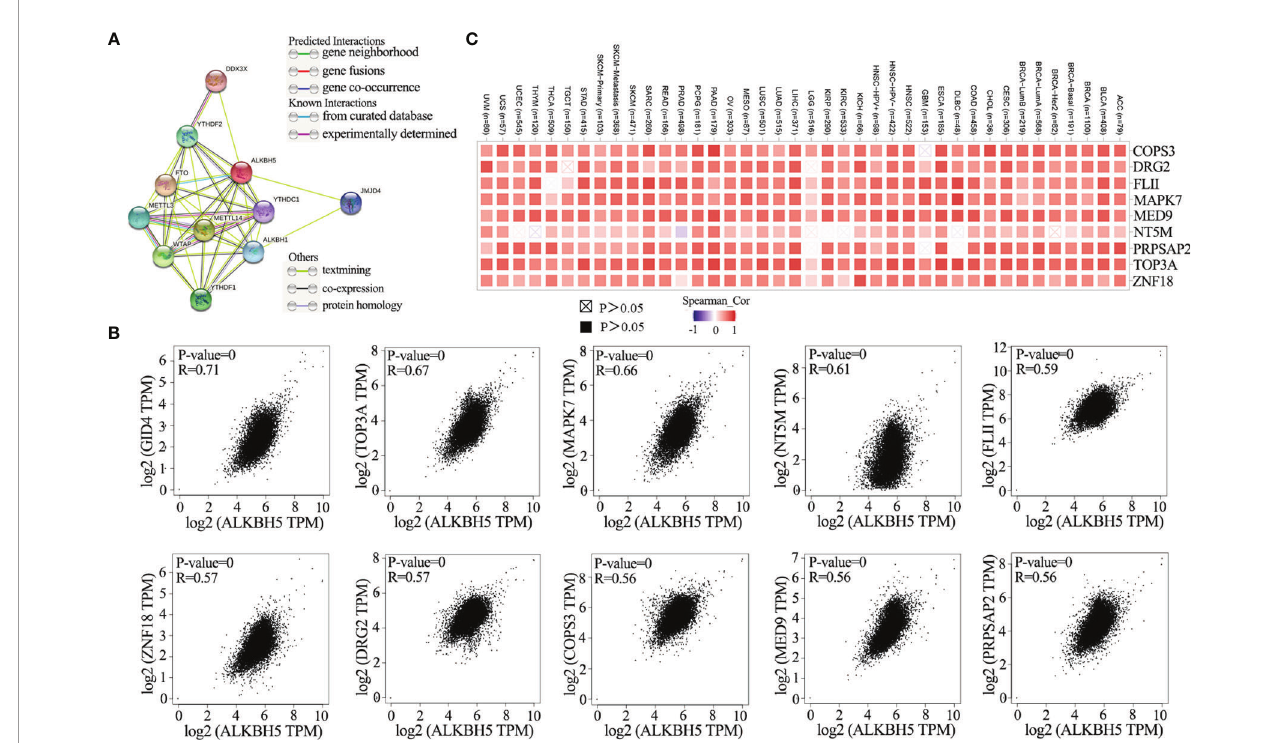
FIGURE 4 | ALKBH5-related genes enrichment analysis in pan-cancers. (A) ALKBH5-binding proteins were displayed using the STRING tool (DDX3X, YTHDC1, YTHDF1, YTHDF2, FTO, METTL3, METTL14, WTAP, JMJD4, ALKBH1); (B) The top 10 ALKBH5-correlated genes was displayed in various tumors and the correlations between ALKBH5 expression and selected targeting genes were analyzed via the GEPIA2 website. These top 10 genes included GID4 (R=0.71), TOP3A (R=0.67), MAPK7 (R=0.66), NT5M (R=0.61), FLII (R=0.59), ZNF18 (R=0.57), DRG2 (R=0.57), COPS3 (R=0.56), MED9 (R=0.56) and PRPSAP2 (R=0.56). The P-value and partial correlation (R) were generated via the purity-adjusted Spearman ’ s rank correlation test; (C) The corresponding heatmap data of ALKBH5 and its positively correlated genes in various tumors via